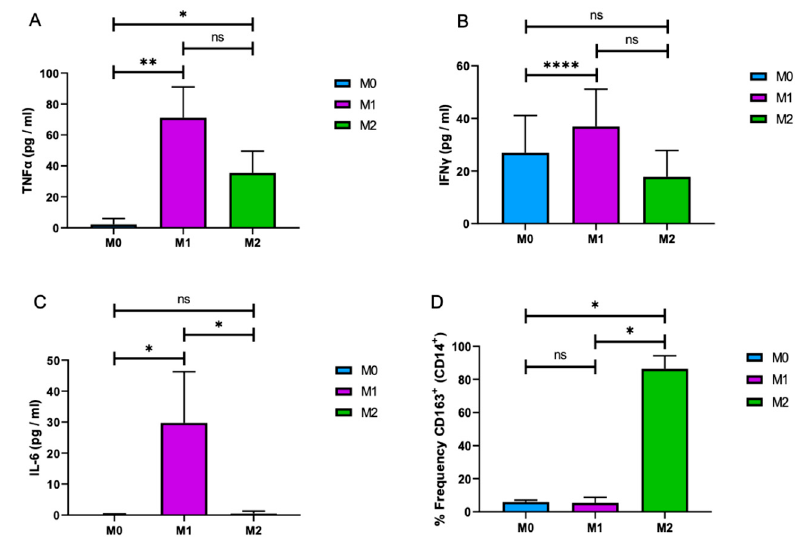
Figure 2. Differential cytokine expression of M1 and M2 macrophages. M1 and M2 macrophages were differentiated from MonoMac-1 cells (M0), and growth media of the cells was subjected to the Enzyme-linked Immunosorbent Assay (ELISA) for TNF- α ( A ), IFN- γ ( B ), and IL-6 ( C ). ( D ) M0, M1, and M2 cells were analyzed by flow cytometry for the frequency of CD163+ and CD14+ macrophages. ( n = 3; * p ≤ 0.05, ** p ≤ 0.01, and **** p ≤ 0.001).